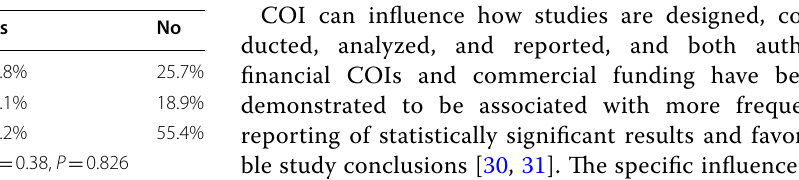
Table 2 Effect of conflicts of interest and industry funding on level of evidence Level of